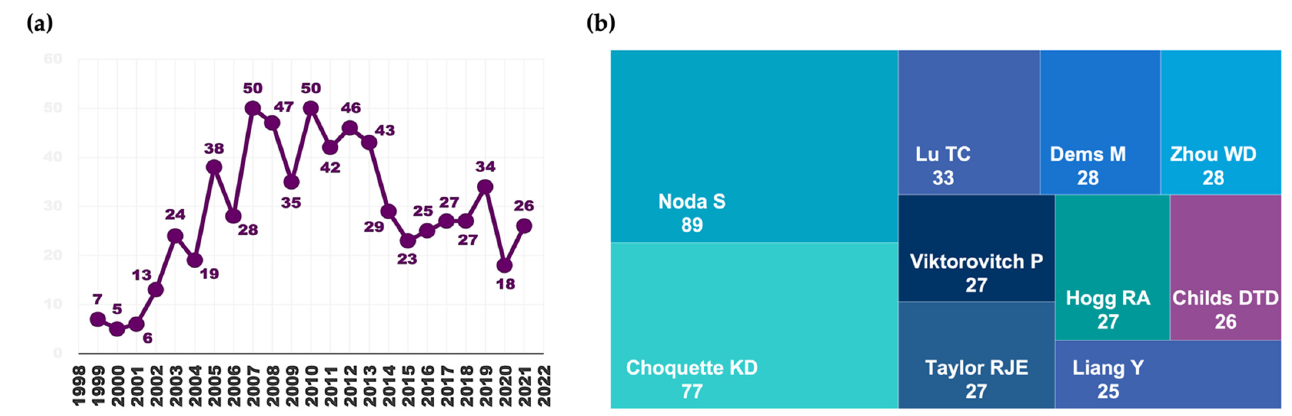
Figure 2. Overview of relevant publications retrieved from Clarivate Analytics’ Web of Science (WoS) bibliometric database. ( a ) The corresponding annual publication counts. ( b ) The top 10 au- thors contributing the most to the area of PCSEL.